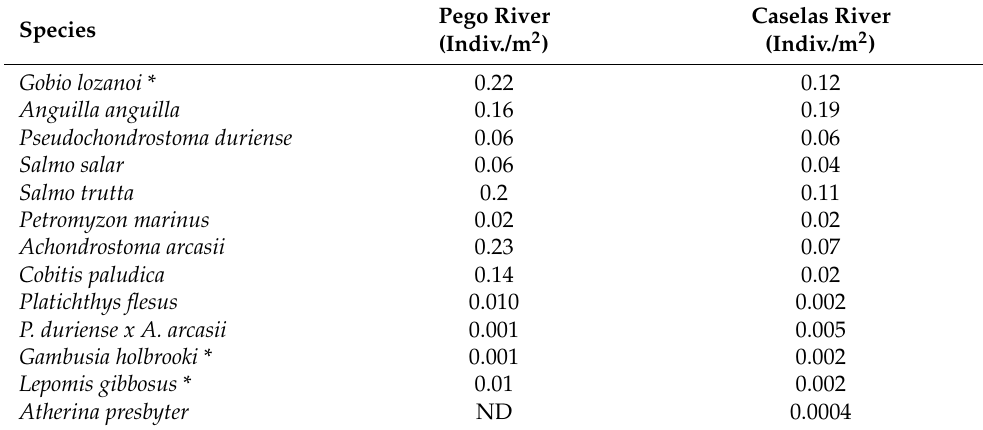
Table 3. Density (individuals/m 2 ) of fish species. ND: not detected (* Non-native species).